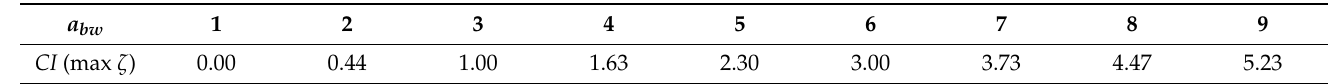
Table 3. The consistency index ( CI